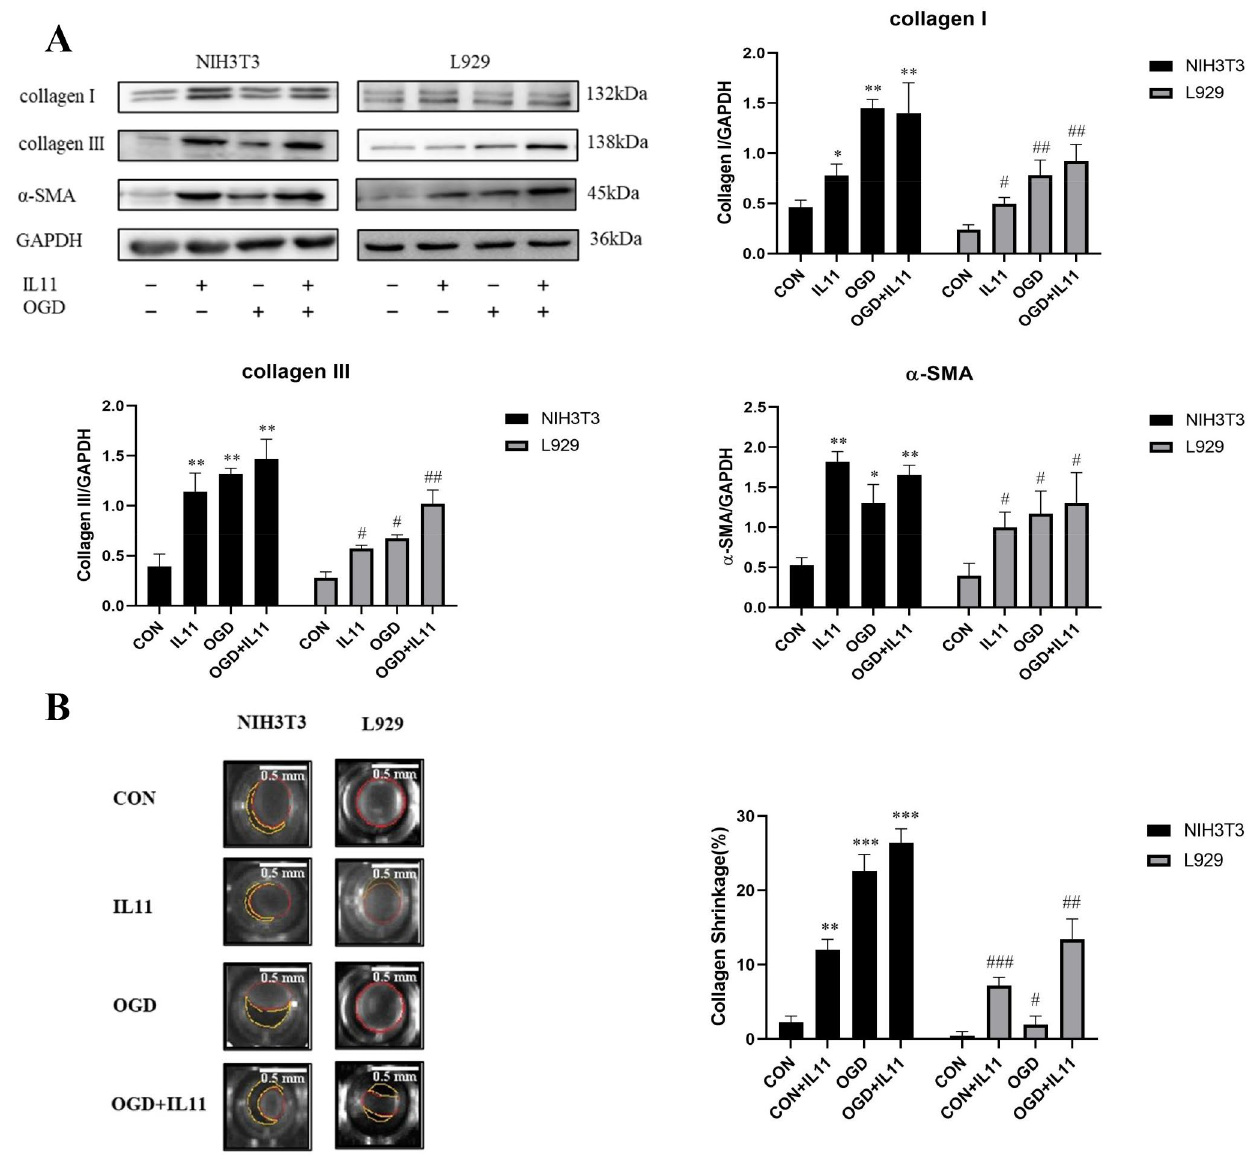
Figure 6. rmIL11 promoted fibroblast collagen expression. ( A ) Western blot analysis and densito- metric analysis of collagen I, collagen III, and α -SMA protein levels after supplementing rmIL11 in NIH3T3 and L929 cells; GAPDH was used as the loading control. ( B ) Quantification of gel contraction and representative image of collagen gel containing NIH3T3 and L929 cells. OGD—oxygen–glucose deprivation; CON—control. The results are presented as the means ± SDs, and Student’s t -test was used to determine the p -value. * p < 0.05, ** p < 0.01, and *** p < 0.001, compared with CON group in NIH3T3 cells; # p < 0.05, ## p < 0.01, and ### p < 0.001, compared with CON group in L929 cells.